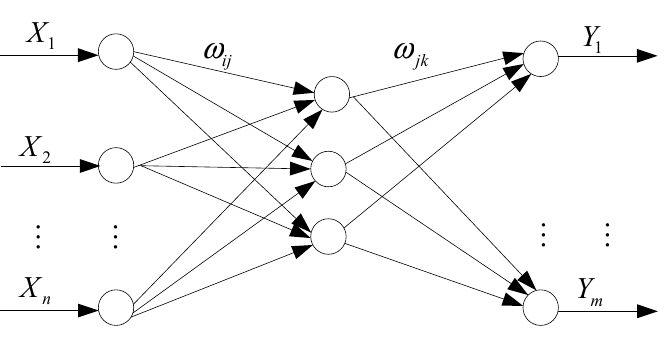
Figure 1. ANN network